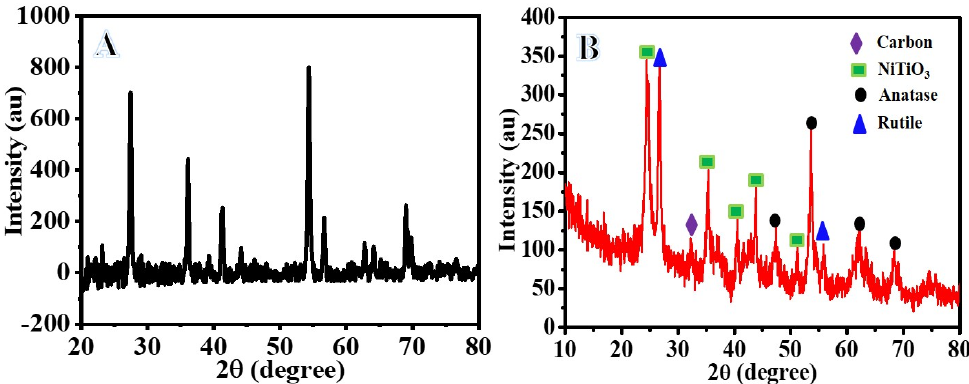
Figure 2. XRD patterns of the produced powder after calcination of electrospun TiIP/PVP ( A ) and NiAc/TiIP/PVP ( B ) nanofiber mats at 800 °C in argon atmosphere.